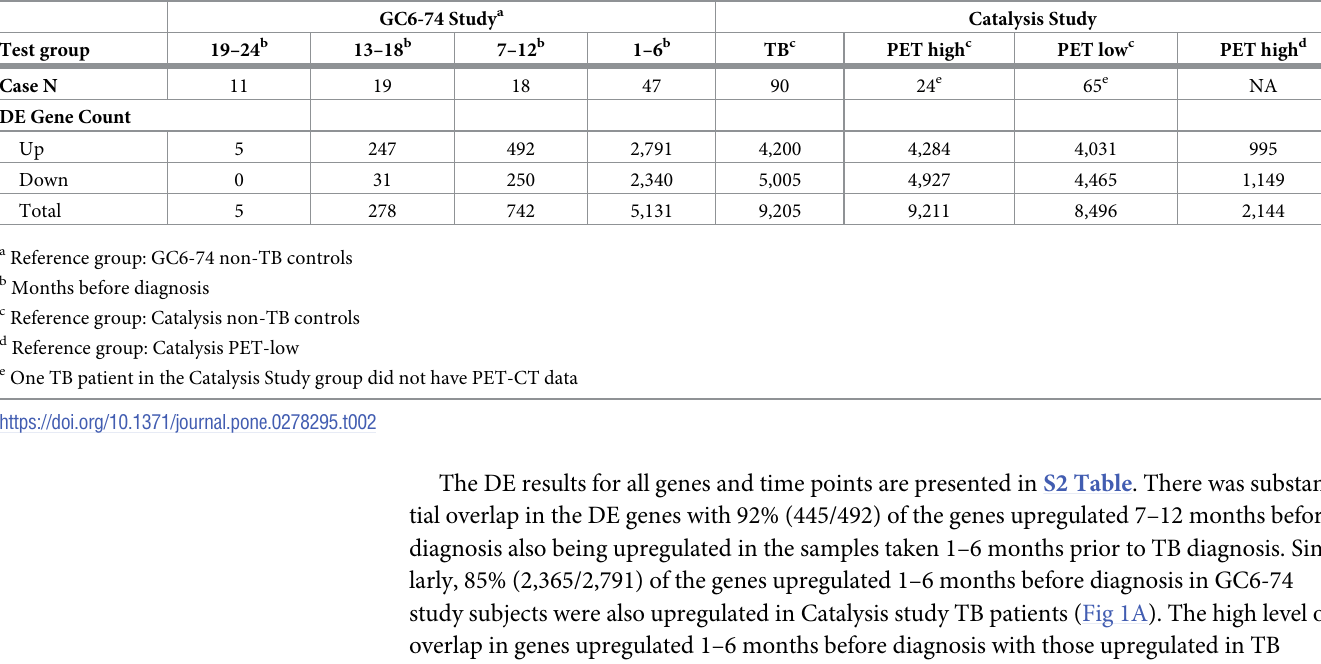
patients illustrates substantial homogeneity in the host response between the two cohorts and provides support for the validity in their comparisons.